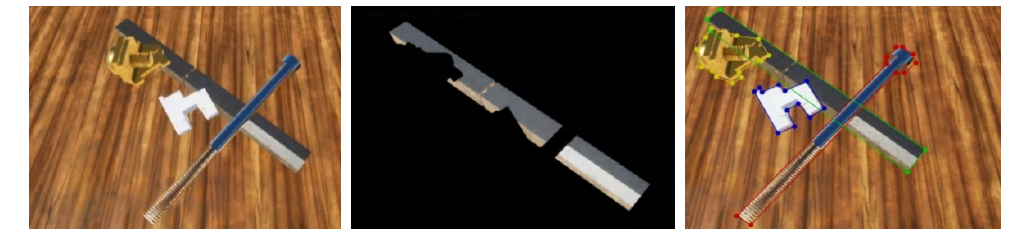
Figure 19. Parts overlay early research implemented into the Unreal Engine.